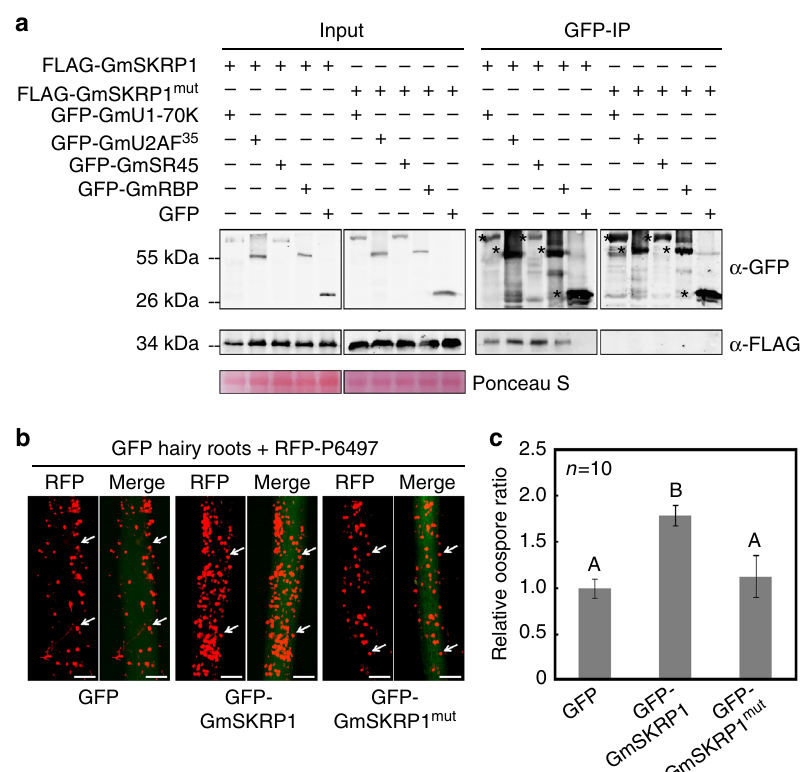
Fig. 5 Association between GmSKRP1 and soybean spliceosome components is required for susceptibility. a GmSKRP1 interacts with complex that contain GmSR45, GmRBP, GmU1-70K, and GmU2AF35 but GmSKRP1 mut does not. The co-immunoprecipitation assay demonstrates that GmSKRP1 interacts with GmSR45, GmRBP, GmU1-70K, and GmU2AF35 in planta, but GmSKRP1 mut does not. The position of expected protein bands are marked by asterisks and proteins loading was determined by Ponceau stain. b Overexpression of GFP-GmSKRP1 mut in hairy roots cannot promote P . sojae infection. Transformed hairy roots were selected based on the green fl uorescence. The fl uorescent hairy roots were inoculated with RFP-expressing P6497 strain of P . sojae . Images were recorded at 48 hpi. The oospores were indicated with arrows. Three independent experiments showed similar results. Scale bars represent 0.25 mm. c Statistic analysis of relative oospore numbers of b . Oospore numbers on inoculated hairy roots were measured. Means and standard errors from ten replicates are shown ( P < 0.01; one-way ANOVA). Experiments were repeated three times with similar